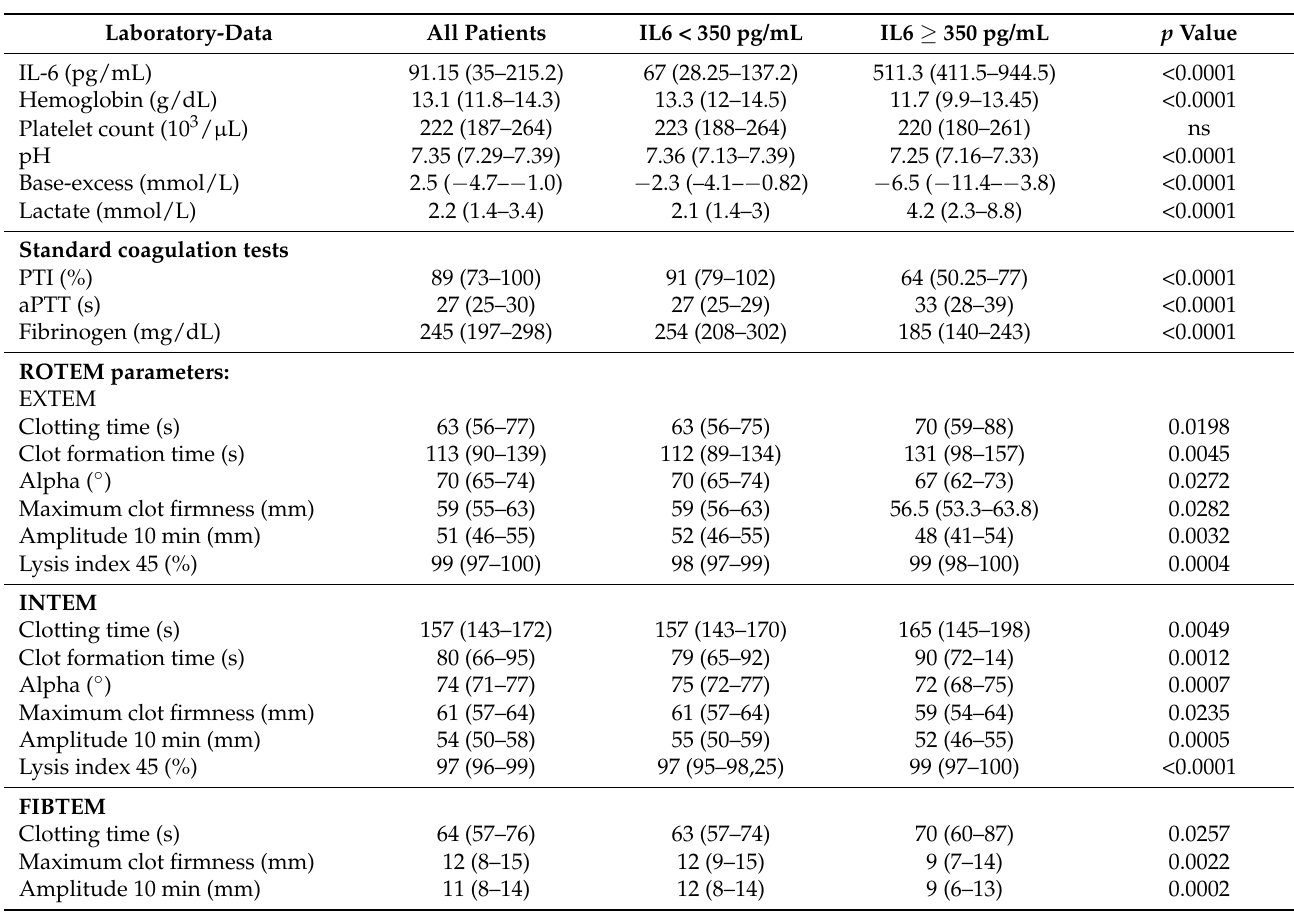
Table 2. Circulating IL-6, and selected blood and coagulation measures upon ER admission.